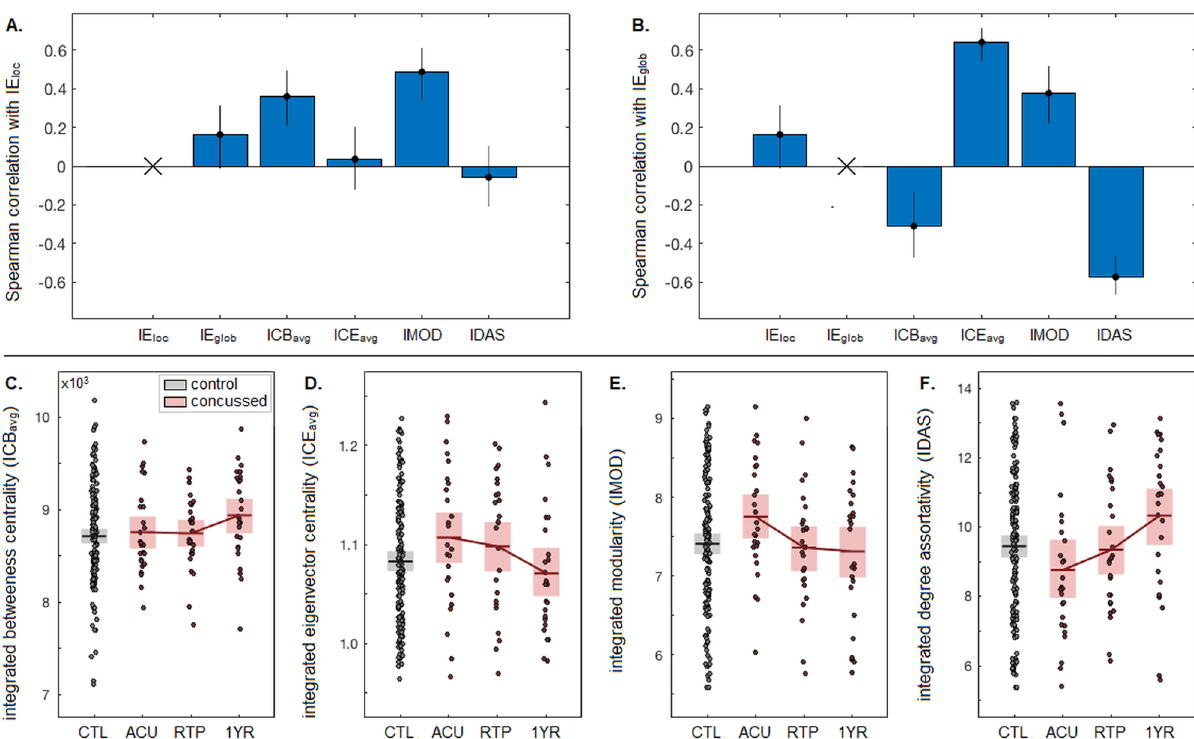
Figure 5. Relationship between network efficiency and other graph-theoretic measures. This includes Spearman correlations of healthy control values, for ( A ) integrated local efficiency ( IE loc ) and ( B ) integrated global efficiency ( IE glob ), with respect to integrated measures of mean betweenness centrality ( ICB avg ), mean eigenvector centrality ( ICE avg ), modularity ( IMOD ) and degree assortativity ( IDAS ). ( C , D , E , F ) depict ICB avg , ICE avg , IMOD and IDAS values for healthy controls (black) and for concussed athletes (red) at each imaging session. Horizontal bars represent sample means and shaded boxes denote the 95%CIs of the mean.